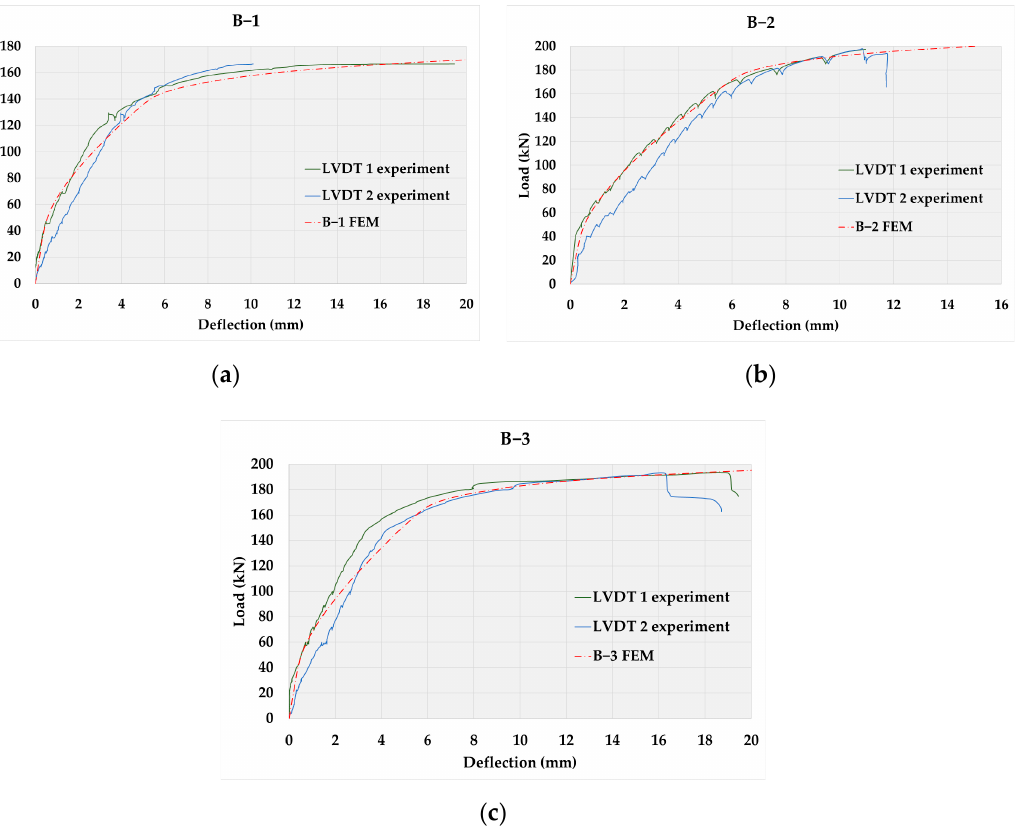
Figure 12. Load vs. deflection curves for the section in the middle of left span—Section I, for: ( a ) Beam B − 1; ( b ) Beam B − 2; ( c ) Beam B − 3. B − 1; ( b ) Beam B − 2; ( c ) Beam B −